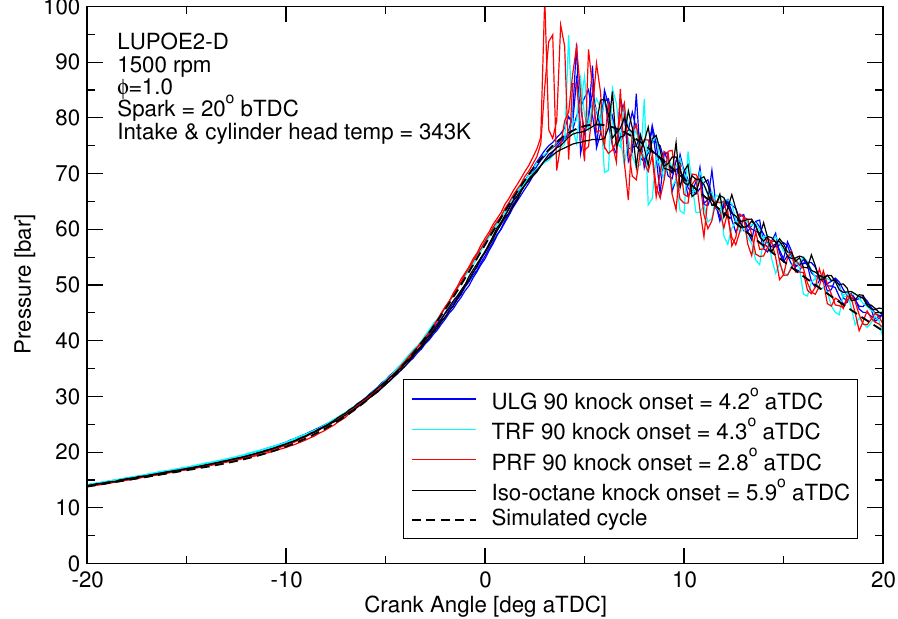
Figure 3. The knocking experimental cycles for the four different fuels which have pressures similar to the pre-knock pressure of